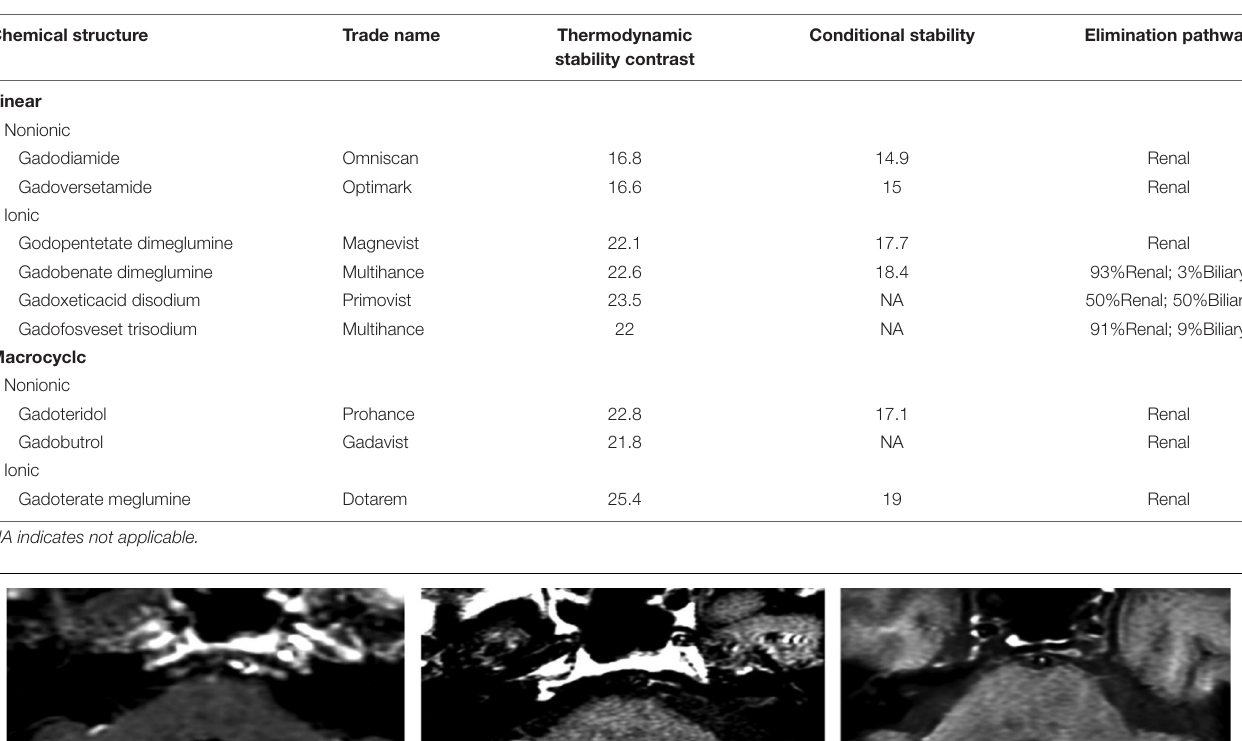
TABLE 1 | Biochemical properties of gadolinium-based contrast agents currently approved for clinical use.